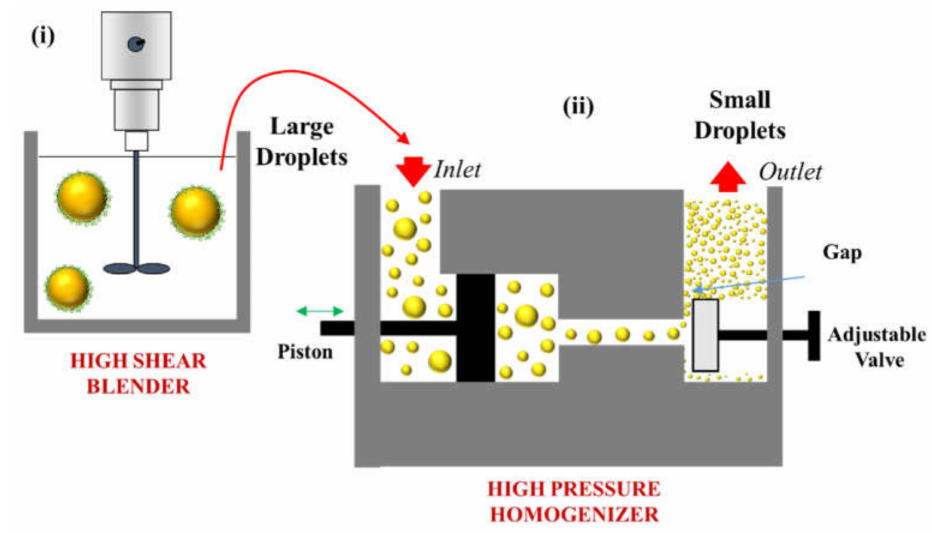
Figure 3. Simplified diagram of the typical two-step procedure used to produce oil-in-water emul- sions using a high-energy method ( i ) a coarse emulsion is formed using a high-shear mixer; ( ii ) a fine emulsion is formed by passing the coarse emulsion through a high-pressure valve